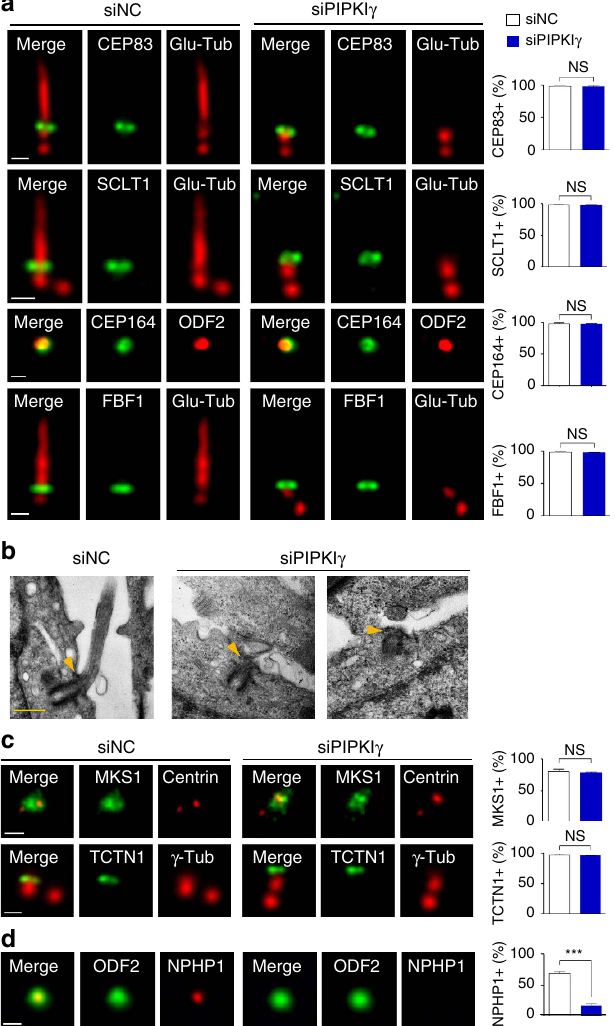
Figure 2 | PIPKI c -depleted cells exhibit normal basal body docking to the plasma membrane. ( a , c , d ) RCTE cells were treated with negative control (siNC) or PIPKI g -specific (siPIPKI g ) siRNAs for 48h and serum starved for 24h, then subjected to indirect IF microscopy analyses with indicated antibodies. Glu-Tub, polyglutamylated tubulin; g -Tub, g -tubulin. Scale bars, 0.5 m m. ( a ) The localization of transition fibre proteins is not affected by PIPKI g depletion. ( b ) The basal body docking to the plasma membrane is not changed by PIPKI g depletion. Control (siNC) or PIPKI g -depleted (siPIPKI g ) IMCD3 cells grown on coverslips were serum starved for 48h and then fixed, scraped off the coverslips, spun into pellets and processed for transmission electron microscopy. Arrowheads point to distal ends of the basal body. ( c ) Localization of the components of transition zone MKS module is not affected by PIPKI g depletion. ( d ) NPHP1 lost its association with the M-centriole/basal body in PIPKI g -depleted cells. Percentage of cells ( n 4 60) exhibiting centrosome/basal body localization of tested transition fibre ( a ) or transition zone ( c , d ) proteins in control or PIPKI g -depleted cells was quantified from three independent experiments and plotted. Error bars represent s.d. NS, no statistically significant difference. *** P o 0.001.